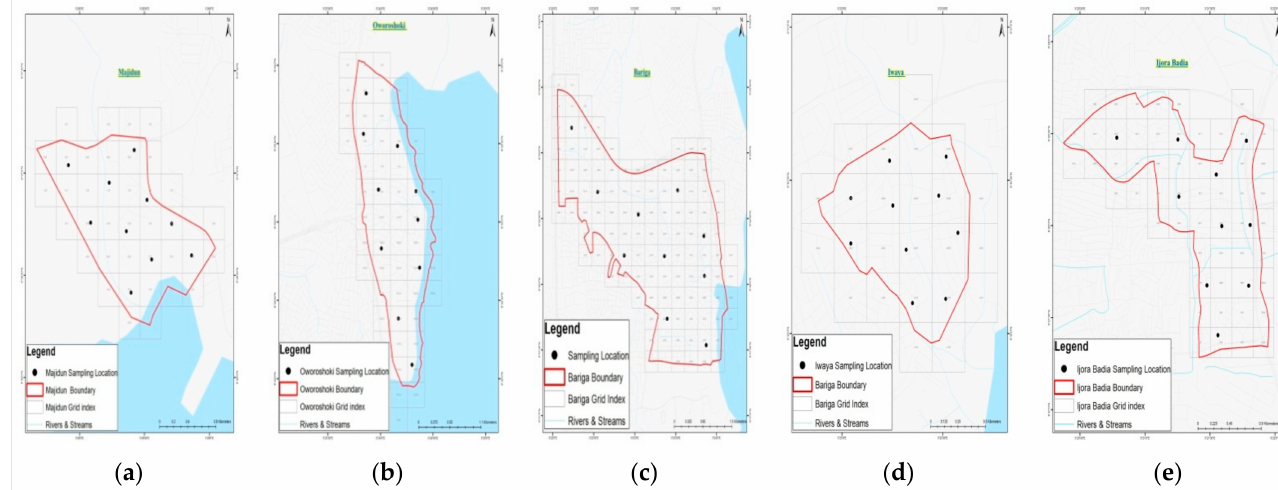
Figure 2. Spatial gradient map of the five selected coastal slum settlements in Lagos metropolis, showing the boundary of each of the slums, sampling design, and sample locations. ( a ) Majidun; ( b ) Oworoshoki; ( c ) Bariga; ( d ) Iwaya; ( e )